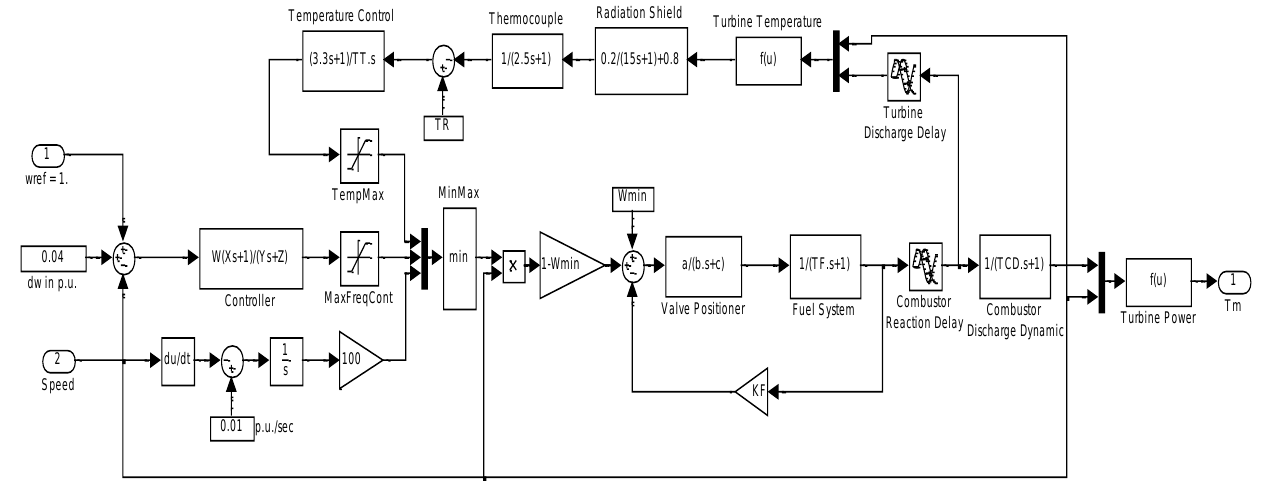
Figure 3. Simulink model presenting realization of simplified single-shaft gas turbine for isolated operation.